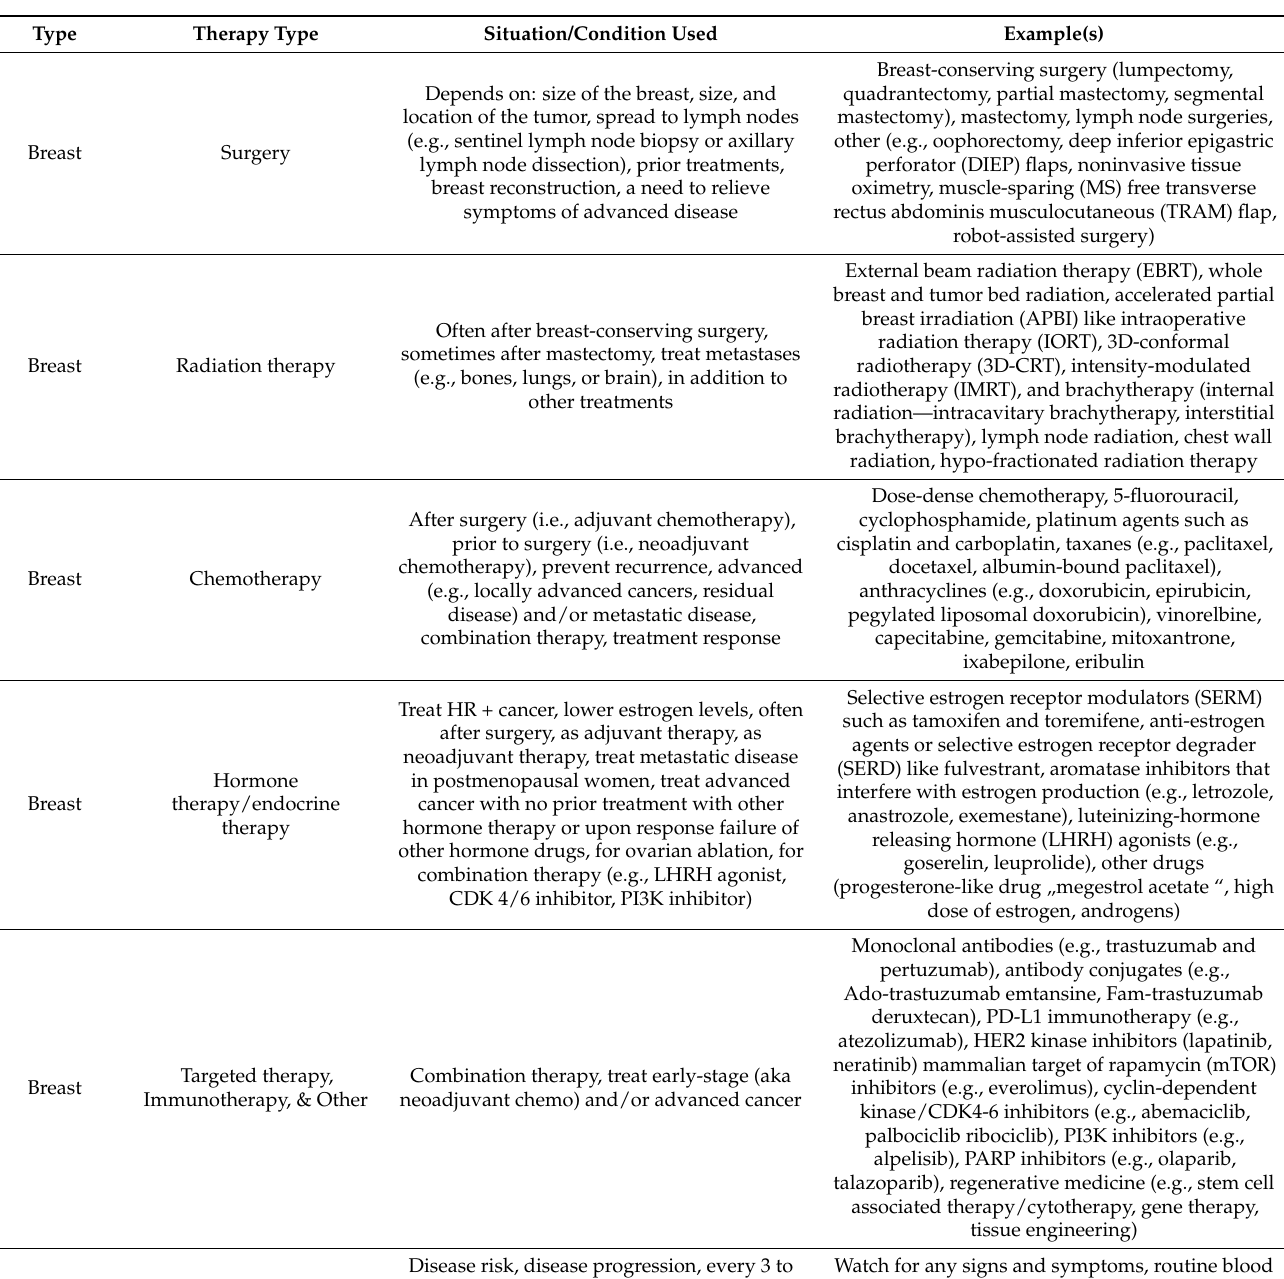
Table 2. Currently trending [165–167] intervention options for breast and prostate cancerous and non-cancerous conditions. (Adapted from Refs. ‘cancer.ca’, ‘cancer.org’, and others